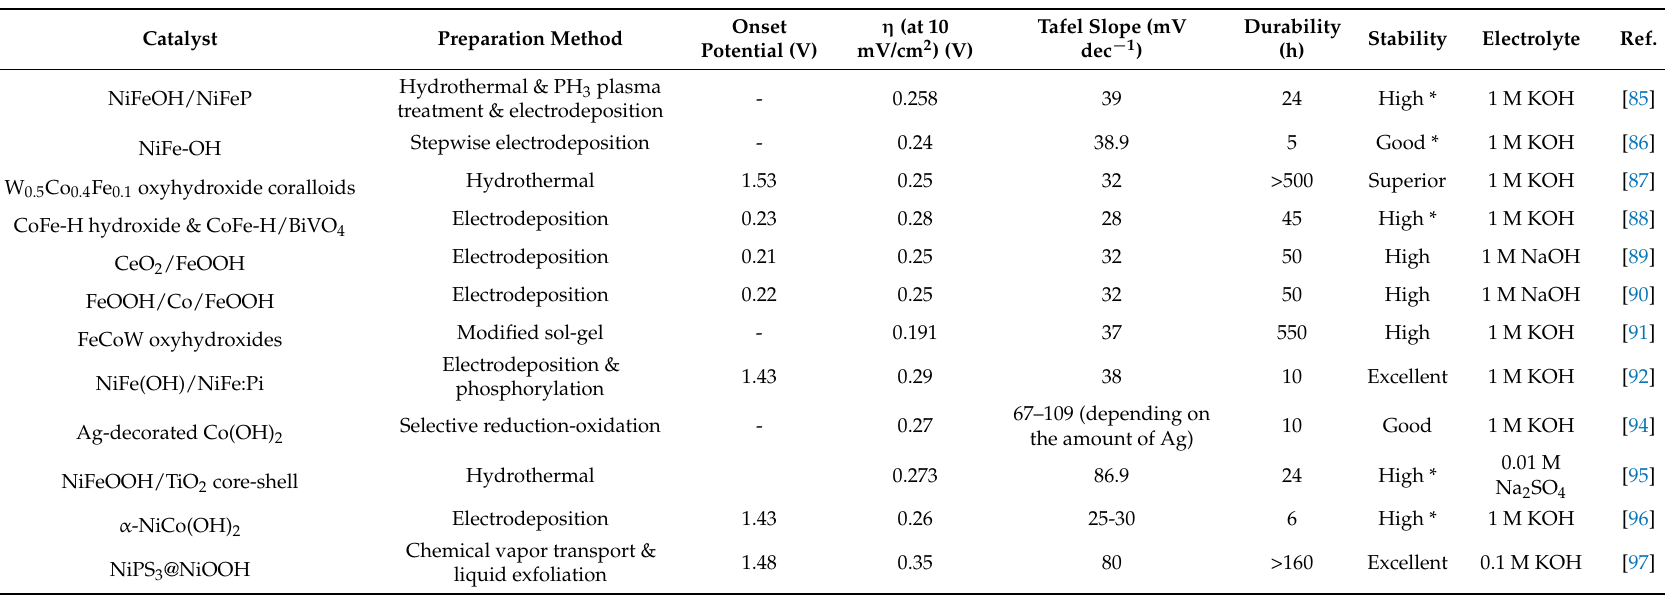
Table 6. Comparison of the electrocatalytic activity of hydroxide and (oxy)hydroxide catalysts (cf. Table 1 for definitions of “durability” and “stability”).